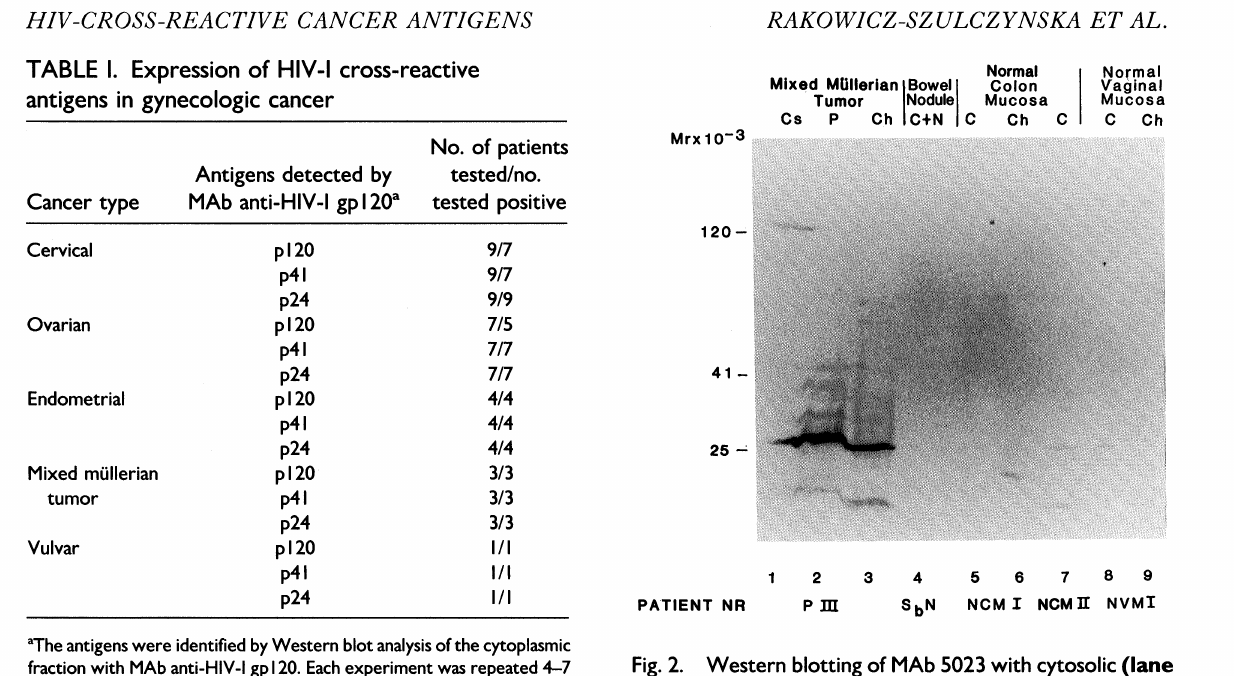
Fig. 2. Western blotting of MAb 5023 with cytosolic (lane I), microsomal (lane 2), and chromatin (lane 3) fractions of mixed millerian tumor (PIll), nonmalignant nodule from the small bowel (lane 4), normal colon mucosa (lanes 5--7), and vaginal mucosa (lanes 8, 9). C, cytoplasm; Cs, cytosol; P, microsomal fraction; Ch, chromatin; C + N, extract from nonfractionated